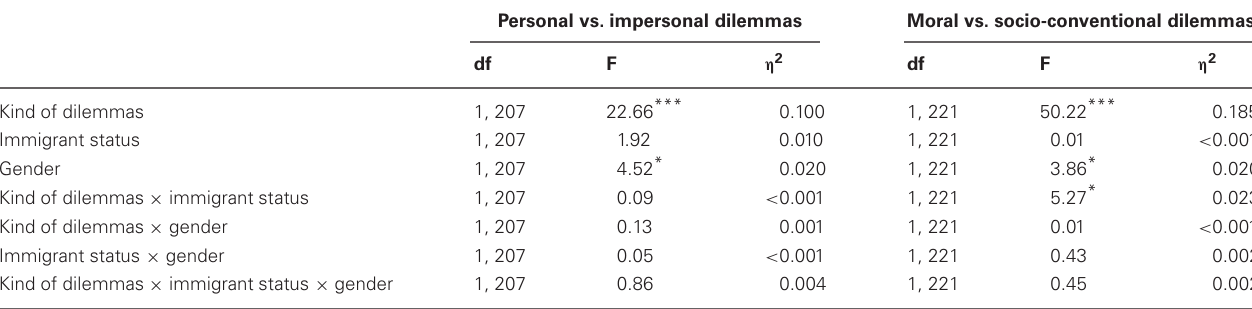
Table 5 | Summary of ANOVA for personal vs. impersonal and moral vs. socio-conventional dilemmas, including immigrant status as fixed factor.